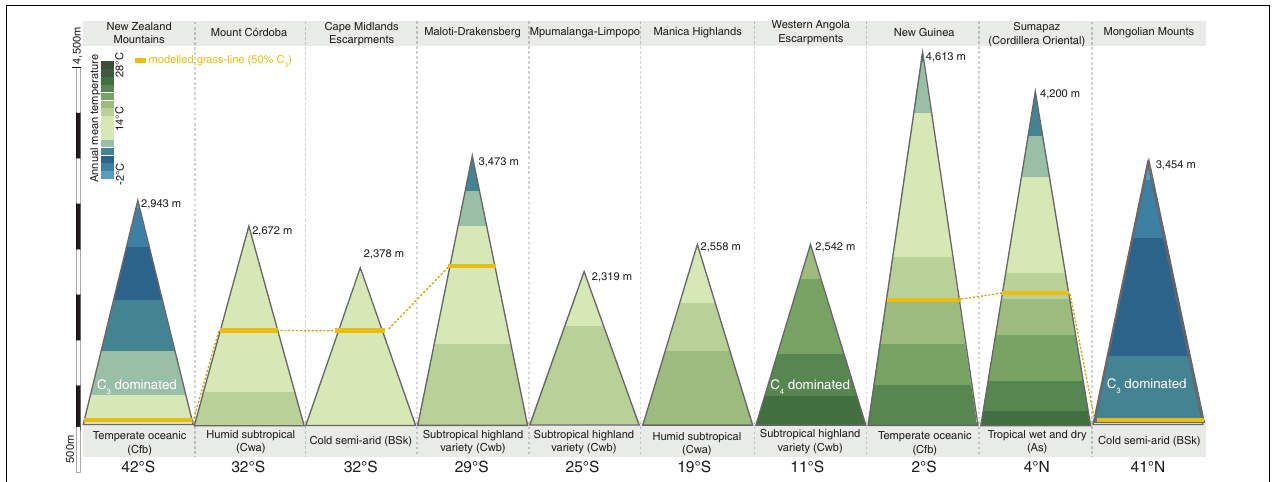
FIGURE 2 | Proportional C 3 composition of grasslands communities along elevation gradients in grassland dominated mountains in Asia, New Zealand, Africa, and South America, and their respective elevation, temperature, climates, latitudes, and modeled grass-line (50% of the genera on the community presenting C 3